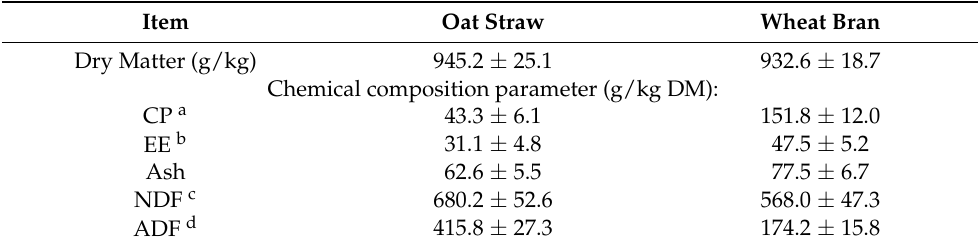
Table 2. Proximate analysis of substrates for solid-state fermentation. Item Oat Straw Wheat Bran Dry Matter (g/kg) Chemical composition parameter (g/kg